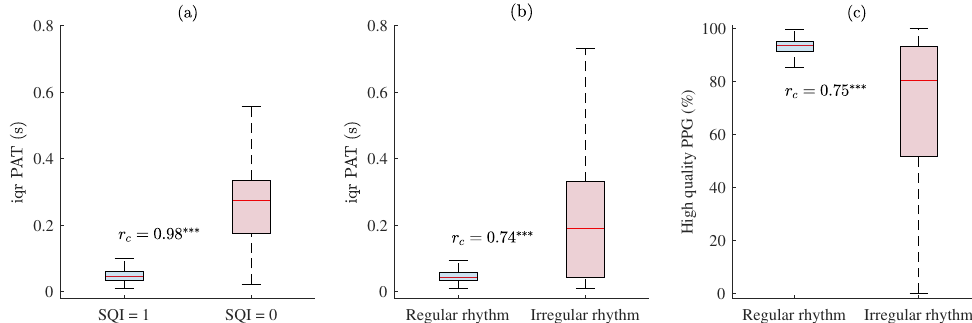
Figure 10. The relationship between PPG signal quality and PAT with estimated matched-pairs r c values. Interquartile range of PAT across all MESA subjects in: ( a ) high- (SQI = 1) and low-quality (SQI = 0) PPG segments, and ( b ) regular and irregular rhythm PPG beat-to-beat intervals; ( c ) the proportion of high-quality PPG during regular and irregular rhythm PPG pulse waves. p < 0.001 and r c ≥ 0.50 is marked ∗∗∗ .